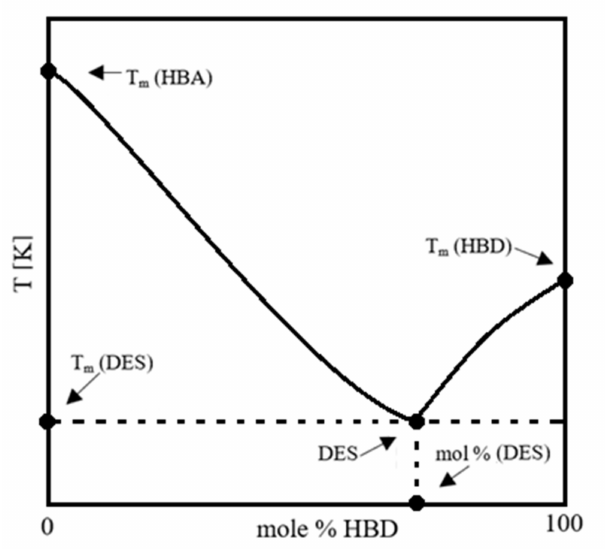
Figure 3. Schematic solid − liquid phase diagram for a binary mixture between an HBA and an HBD. T m stands for the melting point.